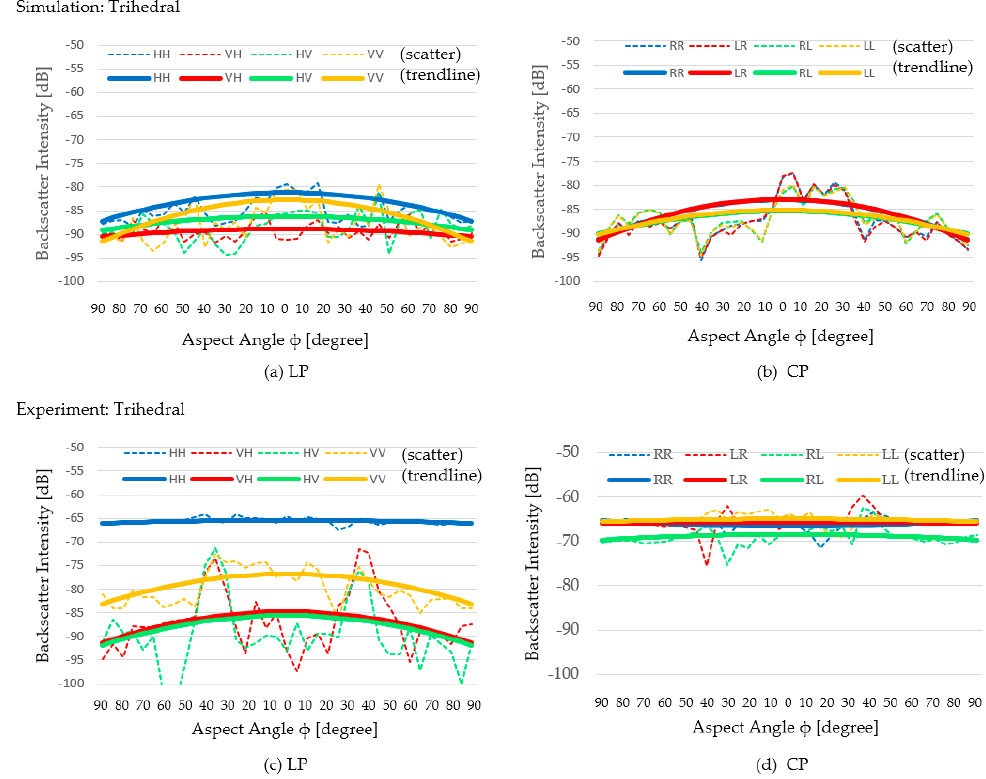
Figure 10. Backscatter intensity of a medium-sized trihedral ( w / λ = 6.4): ( a ) Simulation result of LP, ( b ) simulation result of CP, ( c ) experimental result of LP, and ( d ) experimental result of CP.